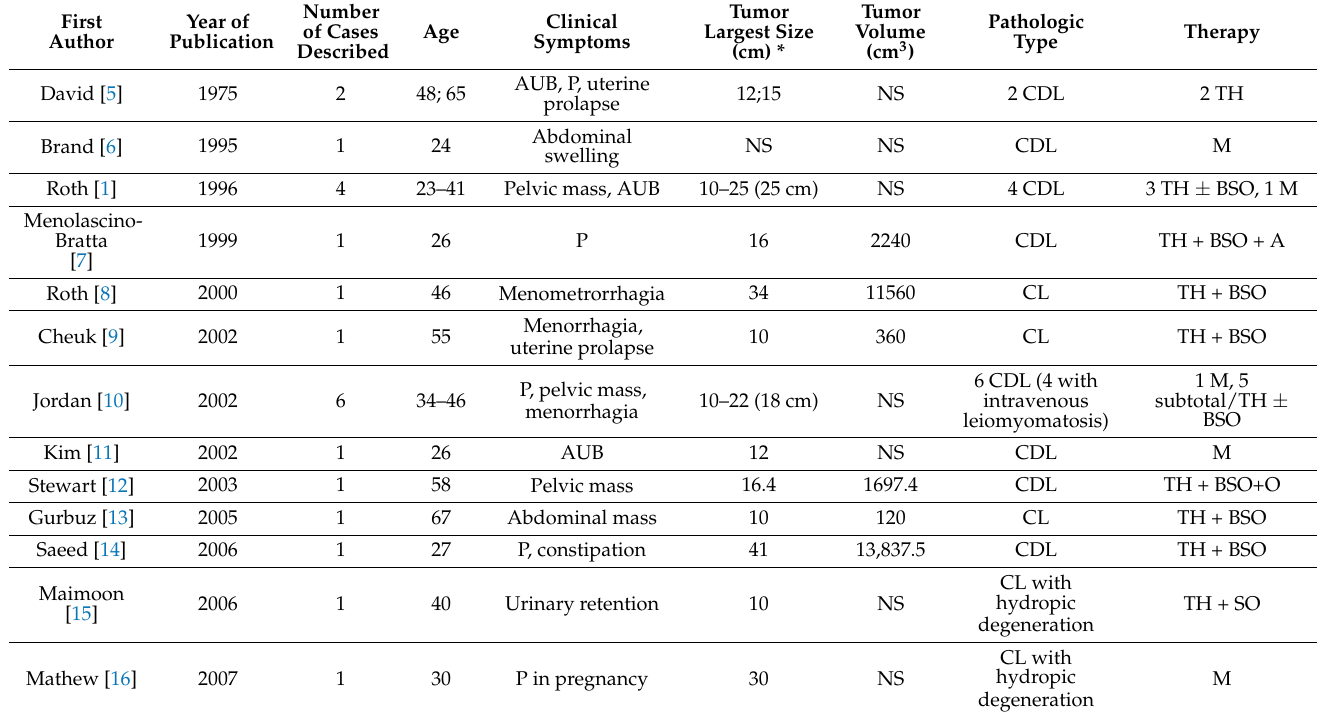
Figure 1. Relationship between the size of the lesion and patient age. It should be noted that the largest number of cases is in the 34–46 age group, when conservative surgery should be proposed due to the possible desire for pregnancy. With advancing age, the size of the lesion decreases, probably due to the effect of hormone depletion typical of the menopause. Table 1. Reported cases in the literature.